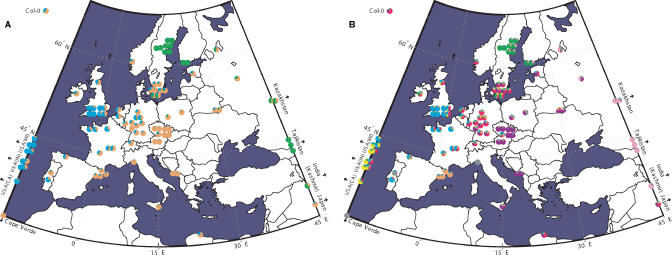
Population Structure in A. thaliana
Each pie chart represents an accession, and is placed on the map according to origin (some of the population samples were too densely sampled and have been shifted for clarity). Accessions sampled outside Europe have been placed at the correct latitude. The exact origin of the standard lab accession Col-0 is not known. The colors and proportions within each pie chart correspond to the output of Structure in Figure 2. (A) K = 3; (B) K = 8.